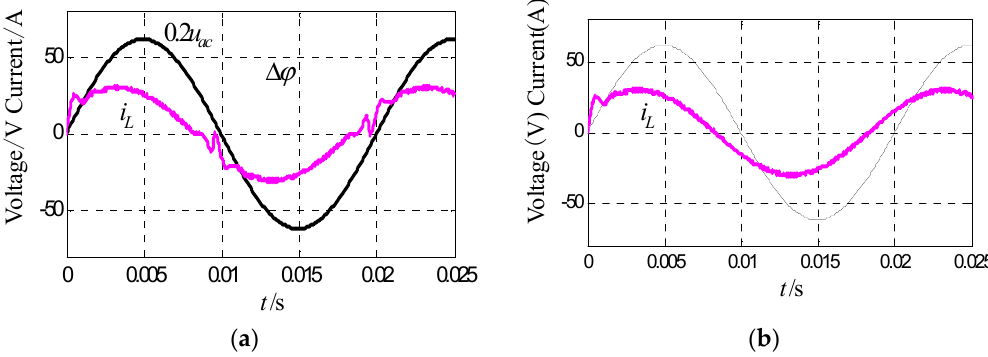
Figure 11. Grid voltage and inductor current of H6. θ = 30°, 5 times attenuation of voltage. ( a ) Modulation I. ( b ) Hybrid modulation mode (HMM).